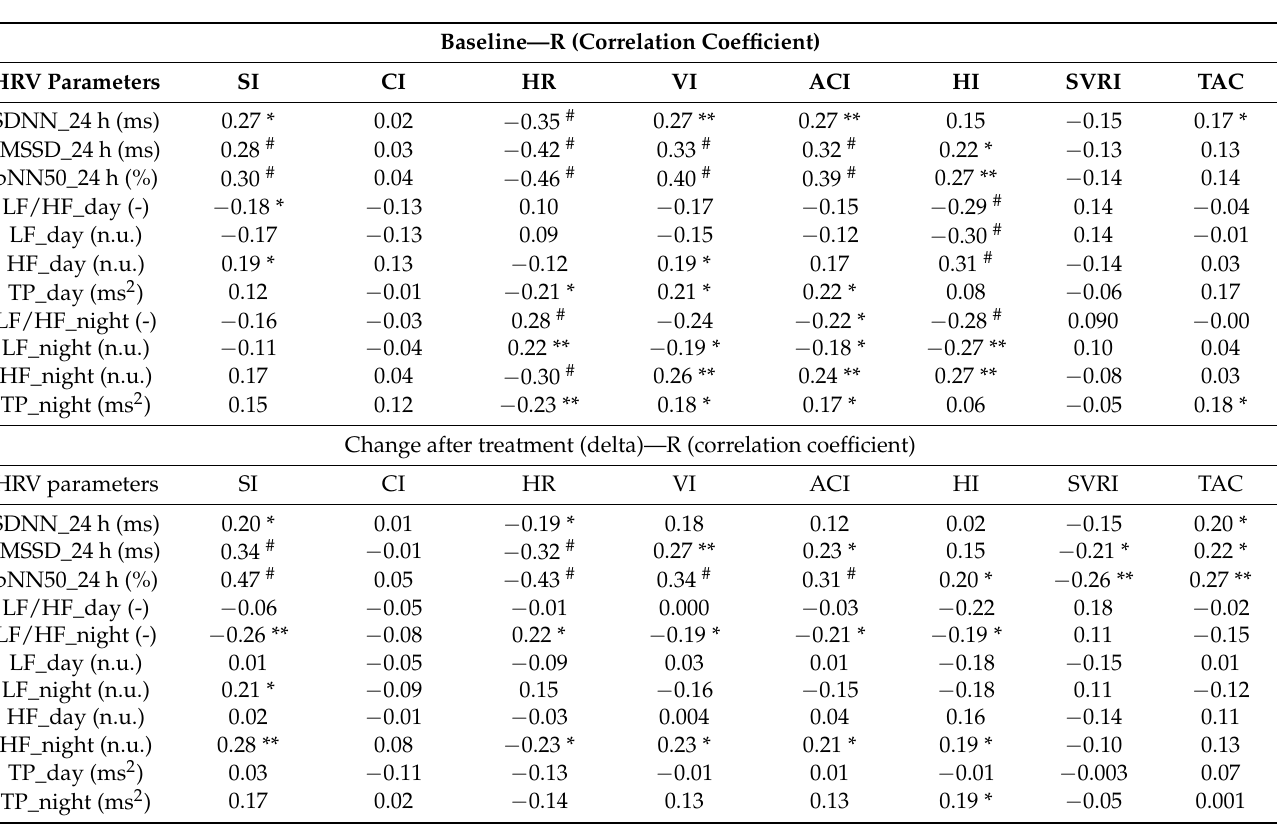
Table 4. Correlations of heart rate variability parameters with impedance cardiography parameters for baseline absolute values and changes (delta) after 12-month